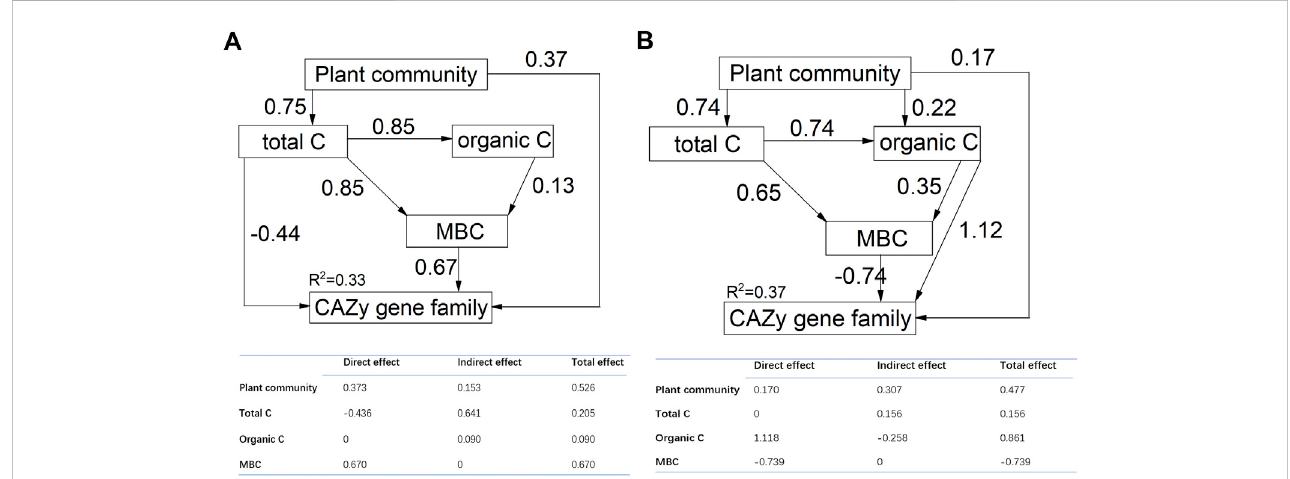
FIGURE 5 Structural equation models (SEM) showing the direct effects of plant community and soil characteristics and their indirect effects on CAZyme families. The numbers above the arrows indicate path coef fi cients. R2 values represent the proportion of variance explained by each variable. Adequate model fi ts are indicatedbyrootsquare meanerrors ofapproximation (RSMEA < 0.06)andTLI(Tucker-LewisIndex > 0.95). Eachpath inthismodelissigni fi cantwith p < 0.05. The table shows the standardized direct, indirect and total effects. (A) :0 – 10 cm; (B) :10 – 20